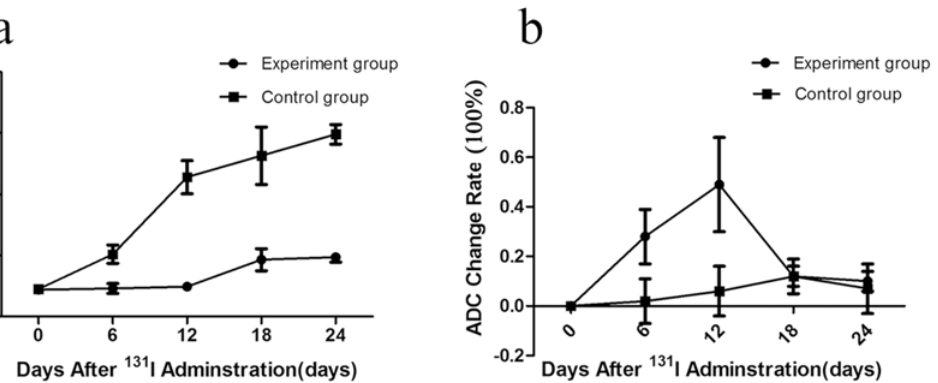
Figure 6. The volume change (a) and ADC change rate (b) of tumor xenografts in experiment and control group after 131 I administration. The MRI result showed that the growth of experimental xenografts was delayed significantly compared to that of control group after 131 I treatment. There was a statistically significant difference in ADC values between the experimental and control groups at day 6, and 12 after 131 I treatment.